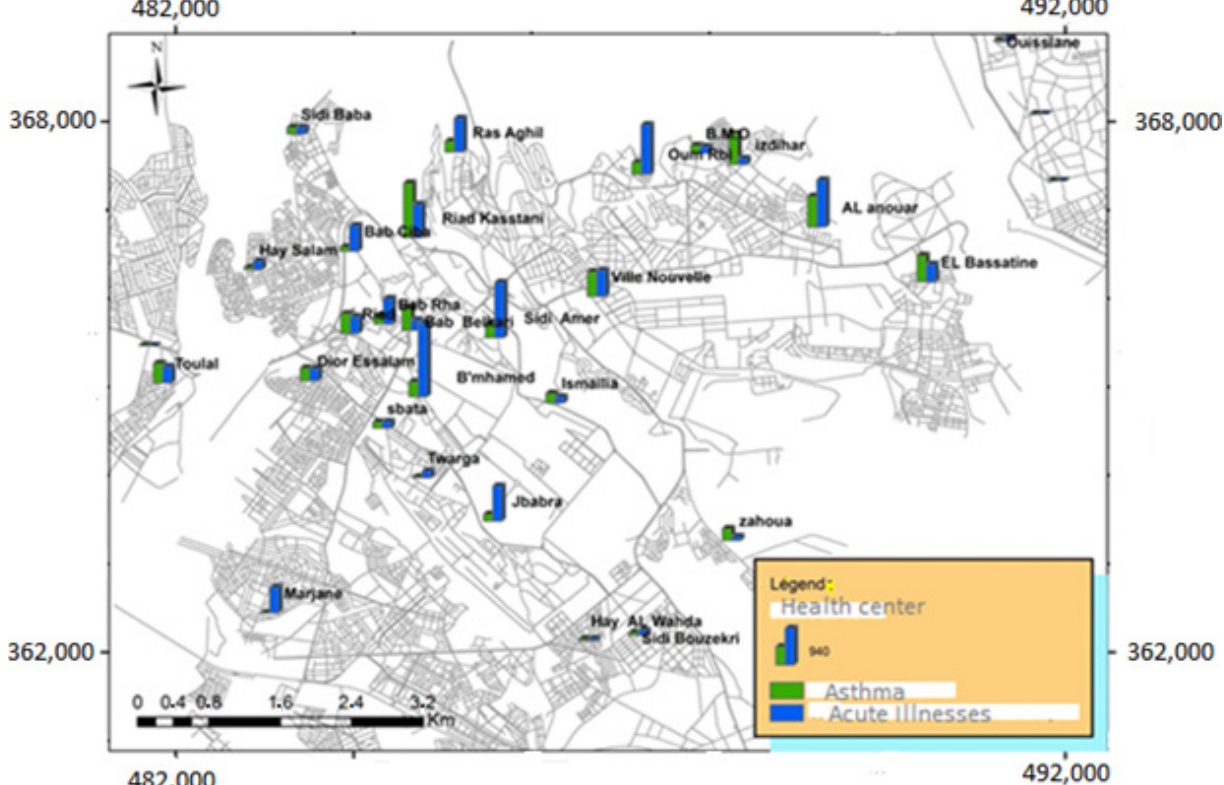
Figure 7. Average annual incidences of respiratory consultations in subjects aged five years and older by health center.